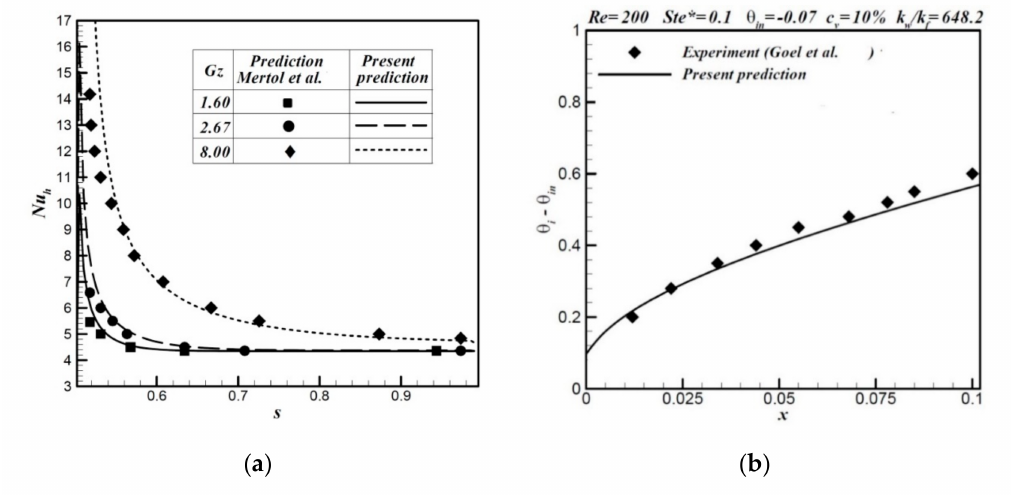
Figure 2. Simulation-result comparison with ( a ) Mertol et al., and( b ) Goel et al.